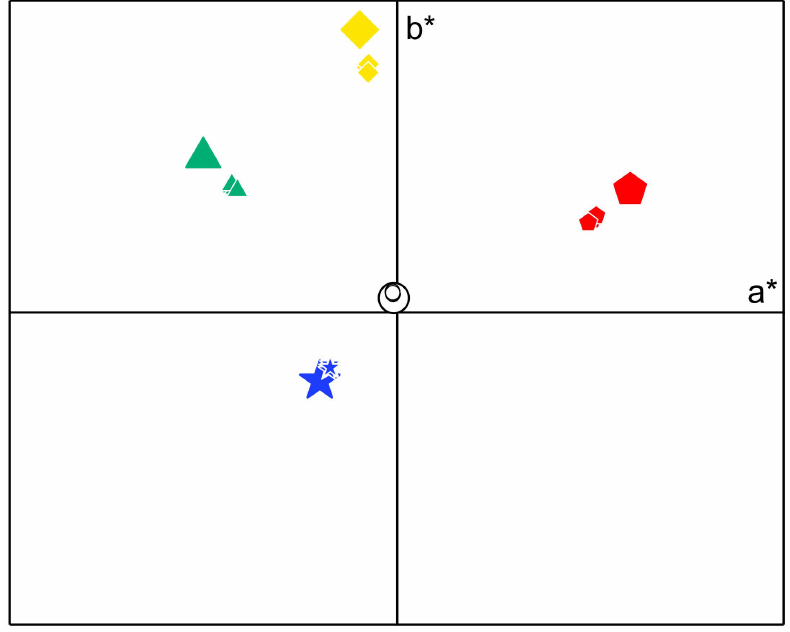
Figure 4. Parameters a* and b* of the CIELAB system for coloured paper sheets uncovered (large symbols) and covered (small symbols) by the EPS films. Table 3. Parameters a* , b* , and L* of the CIELAB system and calculated colour alteration ( ∆ E ab ) that resulted from the covering of coloured paper sheets with the different EPS